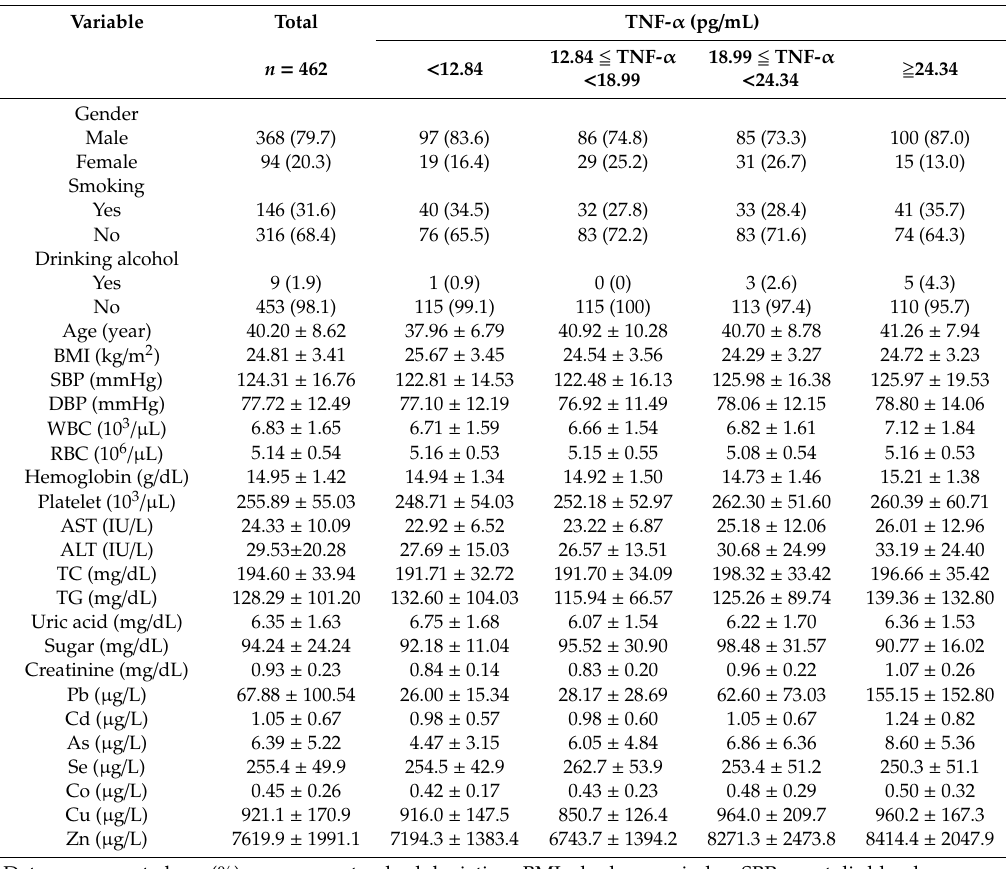
Table 1. Demographic characteristics, biochemical data, and blood element concentration of